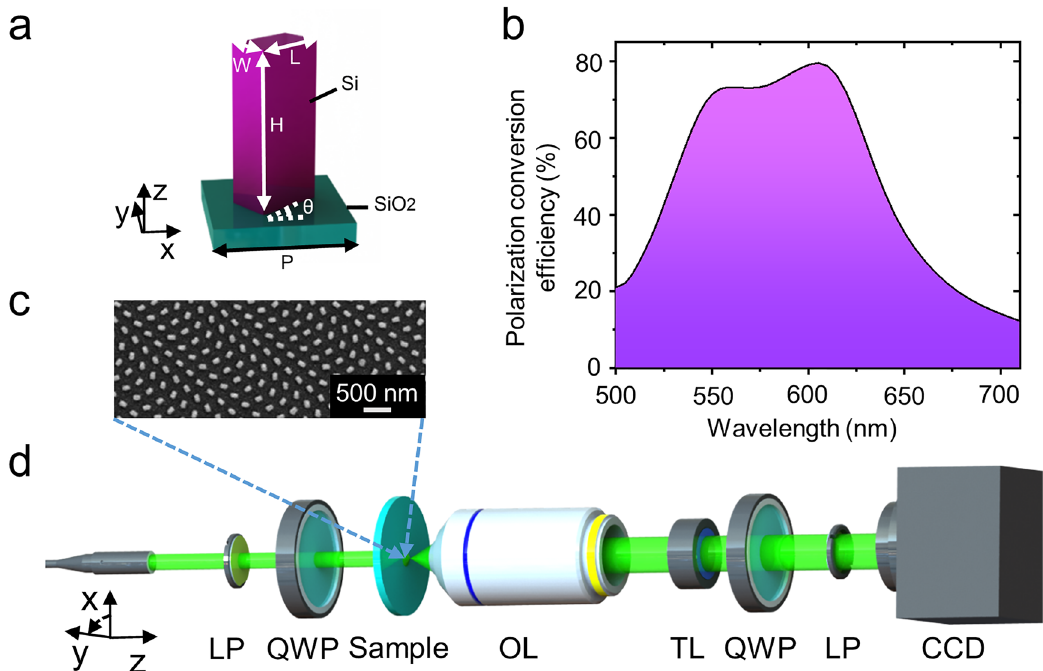
Figure 2: Metasurface design and experimental setup (a) Side view of the meta-atom: silicon nanopillar on a glass substrate indicating L = 130 nm as the length, H = 300 nm as the height, W = 80 nm as the width, and P = 250 nm as the period of the unit cell. (b) The polarization conversion ef fi ciency at various wavelengths. (c) Top view of the SEM image of the fabricated metasurface sample. Scale bar: 500 nm. (d) Schematic of the Bessel beam array generator operating in the transmission mode and experimental setup for optical imaging of the generatedpattern.TheincidentLCPlightilluminatesthegeneratoralongthepositive z -axis.LP:linearpolarizer;QWP: λ /4quarter-waveplate; Sample: metasurface; OL: objective lens; TL: tube lens; CCD: charge-coupled device